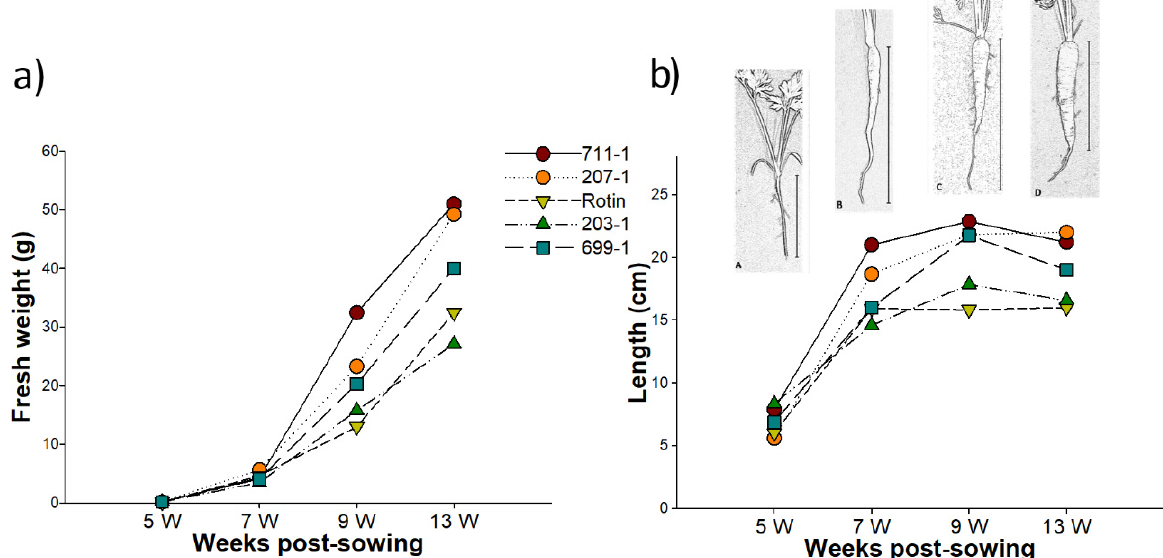
Figure 1. Measurements of carrot tap roots at 5, 7, 9, and 13 weeks post sowing. ( a ) Fresh weight (g) and ( b ) root length (cm) with a carrot scheme representing the general aspect of carrot tap roots at (A) 5, (B) 7, (C) 9, and (D) 13 weeks post sowing. The vertical bar in (b) indicates the part of the tap root used for length measurement.